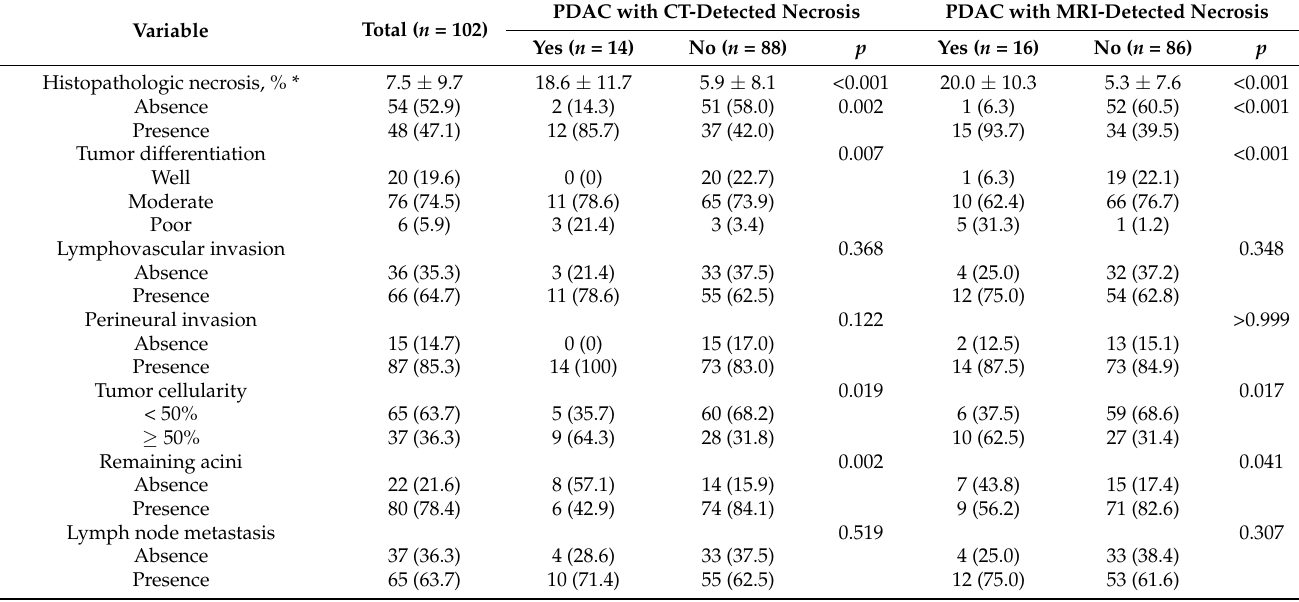
Table 2. Summary of histopathologic findings of PDAC according to imaging